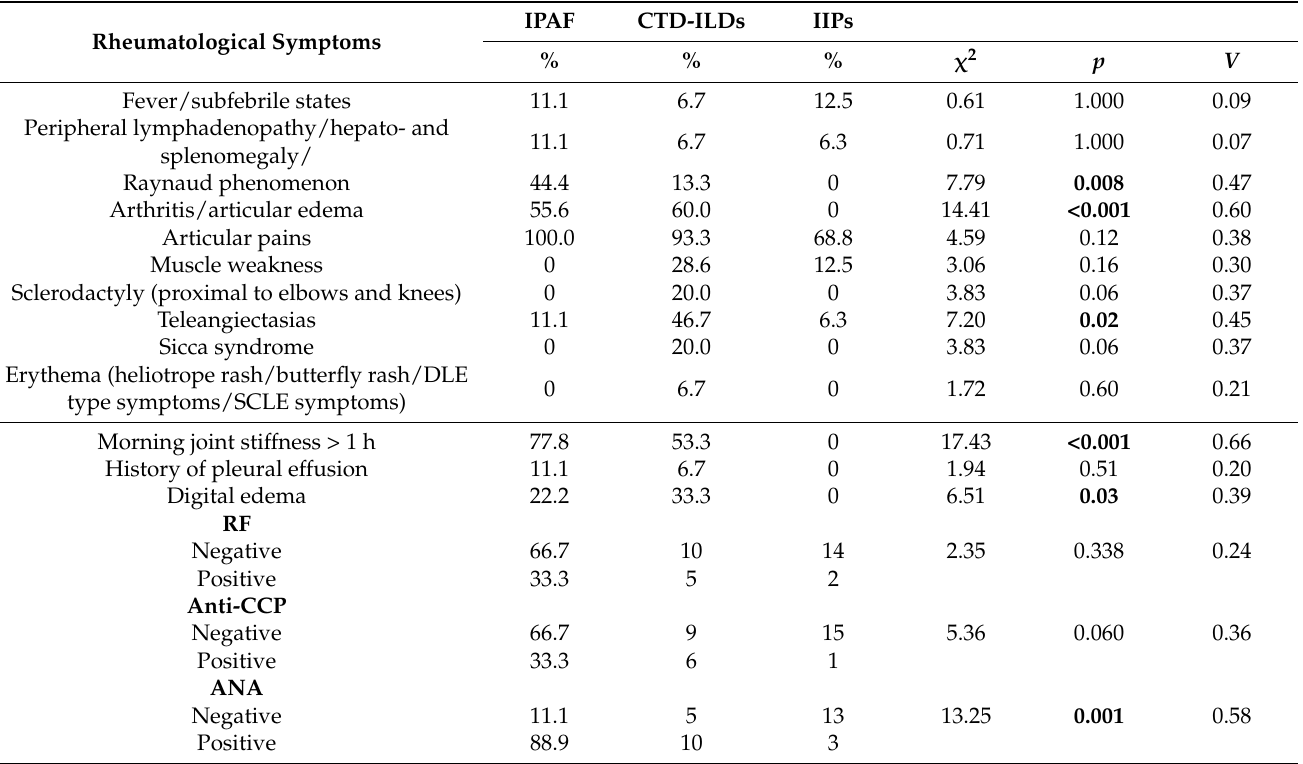
Table 3. Frequency analysis with Pearson’s χ 2 test or Fisher–Freeman–Halton exact test for rheuma- tological symptoms by group membership and autoantibodies